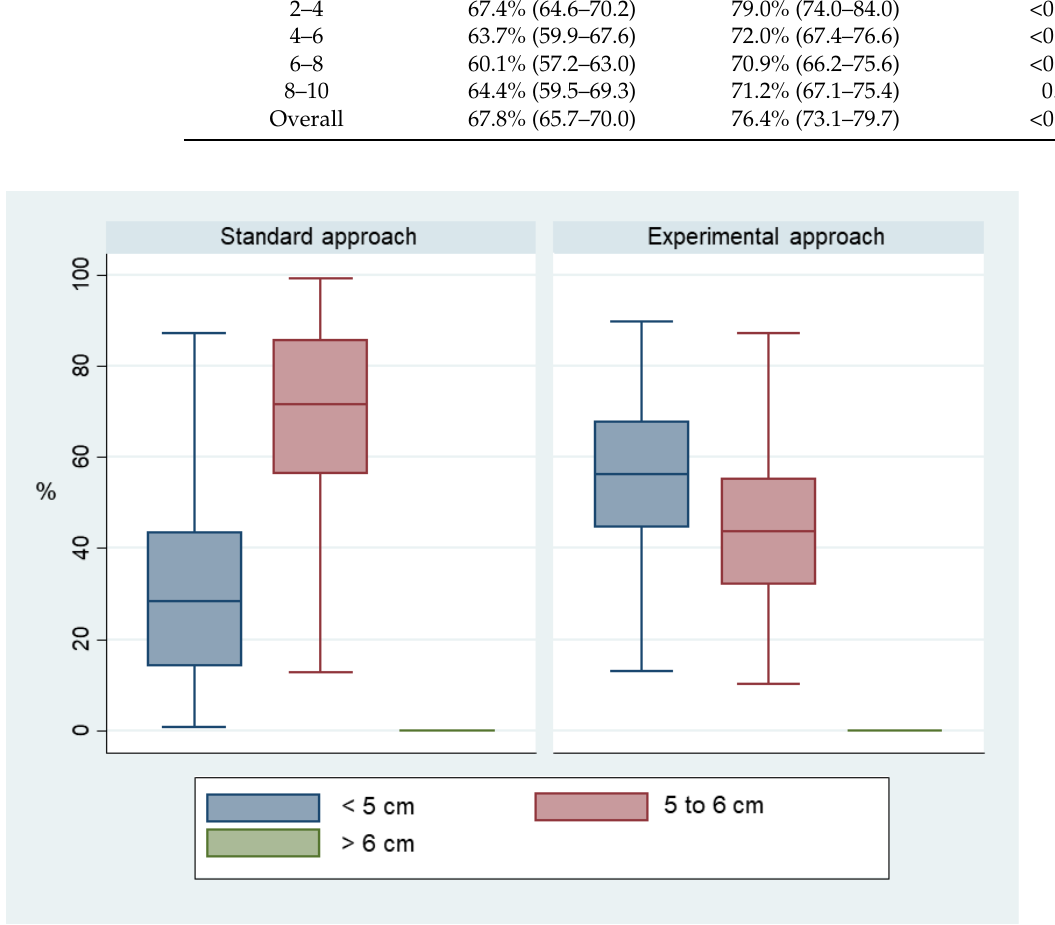
Figure 3. Proportions of compressions below, within and above depth target value. Mean compressions rates were similar in both groups (116 cpm (95% CI 112–120) in the experimental group versus 115 cpm (95% CI 110–119), p = 0.65), with a similar proportion of within-target compressions between groups (median (Q1; Q3) 78.2% (52.9; 92.6) versus 89.9% (62.3; 96.9), p = 0.40) (Figure S1). There was no difference regarding chest recoil (median (Q1; Q3) 97.9% (86.7; 99.6) in the experimental group versus 98.9% (92.4; 99.5), p =